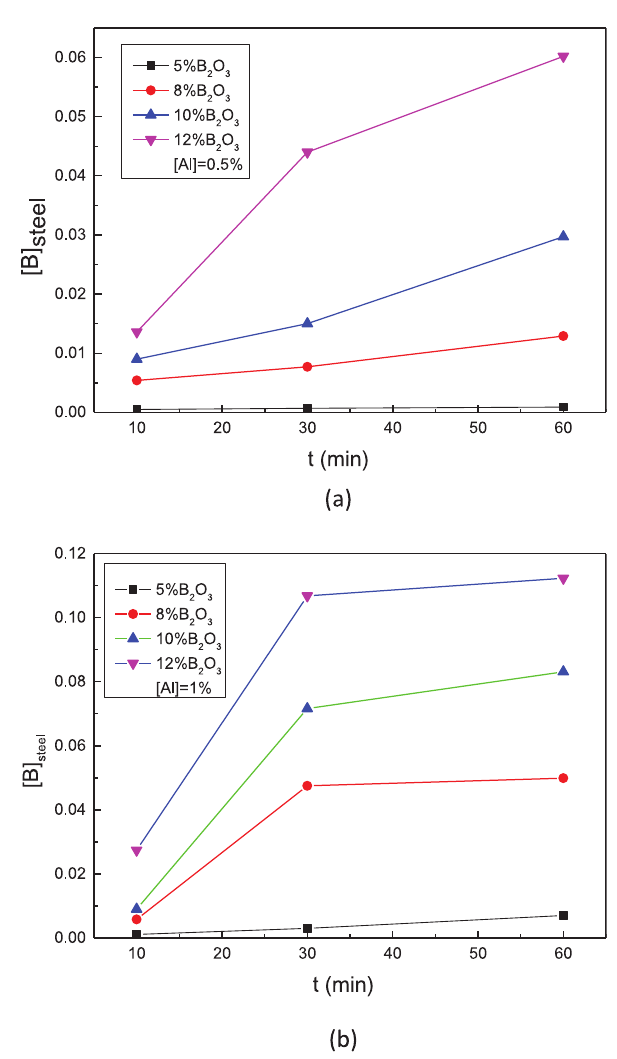
Figure 4: The change of [B] content of high Al steel with different B 2 O 3 addition in CaO-Al 2 O 3 -based mold flux.